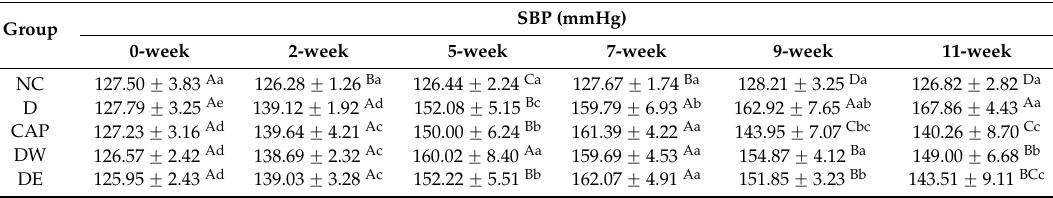
Table 2. Effects of administration of the extracts from TWK10-fermented soymilk on systolic blood pressure in DOCA-salt induced hypertension and its associated dementia